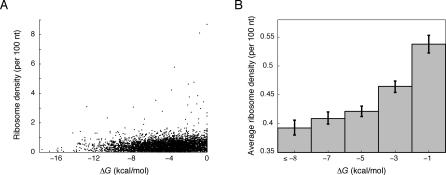
Comparison between Ribosome Densities and Folding Free Energies of 5′-UTRs(A) Scatter plot of mRNA ribosome density and folding free energy of the 5′-UTR (ΔG) for 5,888 ORFs.(B) ORFs were grouped based on the change in free energy (ΔG). For each energy group, the average ribosome density (±SEM) is shown. From left to right, the number of ORFs in each energy group used to calculate the average density was 573, 796, 1,214, 1,438, and 1,187.